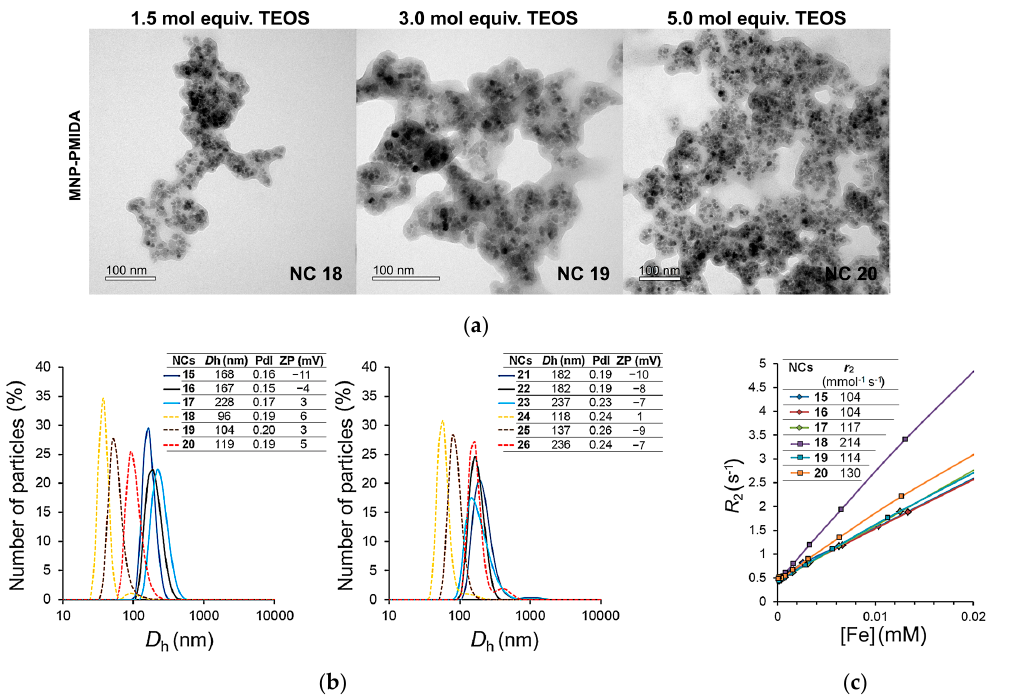
Figure 4. ( a ) TEM images of NCs 18 – 20 . ( b ) DLS data for colloidal solutions of Dox-loaded NCs 15 – 26 . ( c ) Relaxation rate ( R 2 ) of colloidal solutions of NCs 15 – 20 .